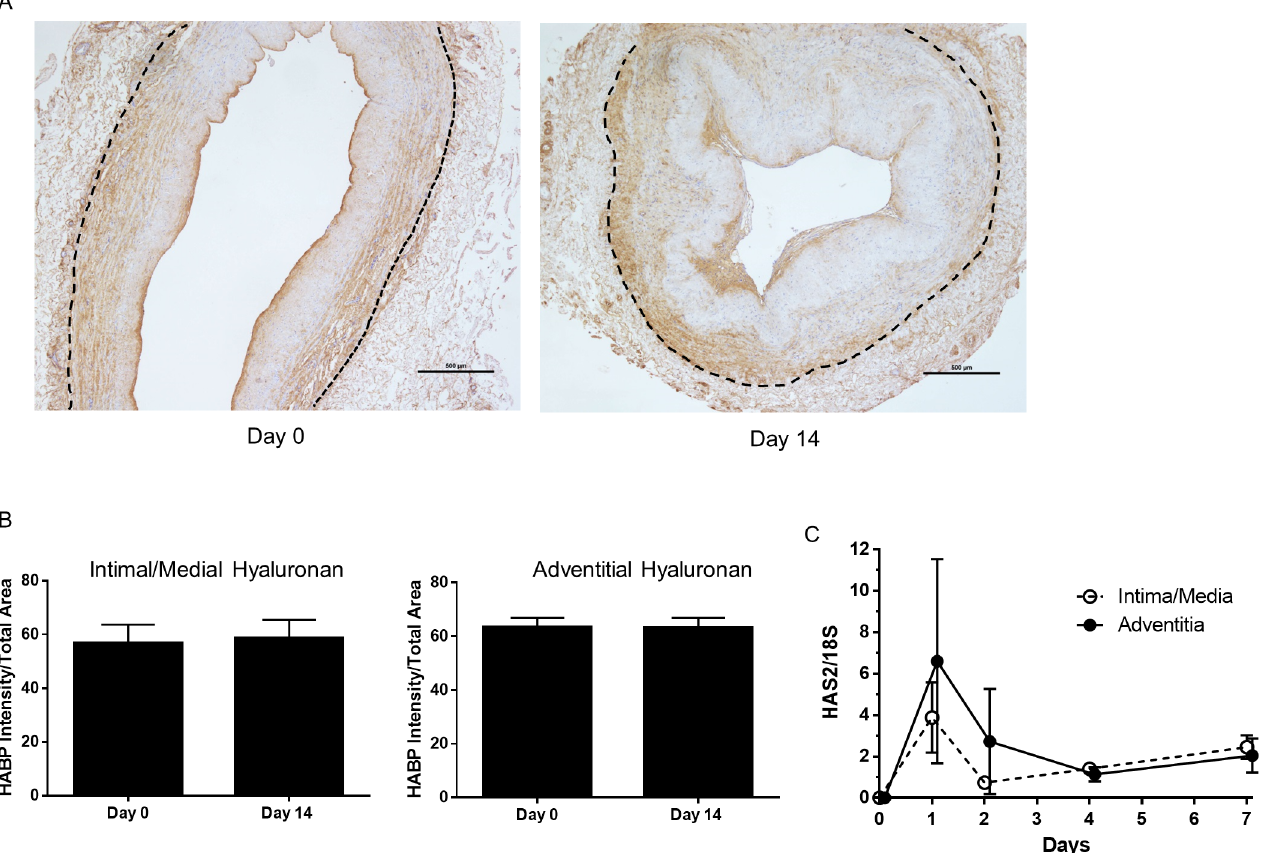
Fig 4. Hyaluronan staining in vein rings. (A) Hyaluronan (HABP) staining in pre-culture and 14-day cultured floating vein rings. Dotted line indicates the adventitial/medial boundary. Scale bars indicate 500 μm. (B) HABP quantification for the intima/media and adventitia. N = 19 veins. (C) Induction of HAS2 message in cultured intimal/medial and adventitial tissue. N = 3 veins day 0, N = 6 veins days 1–7.